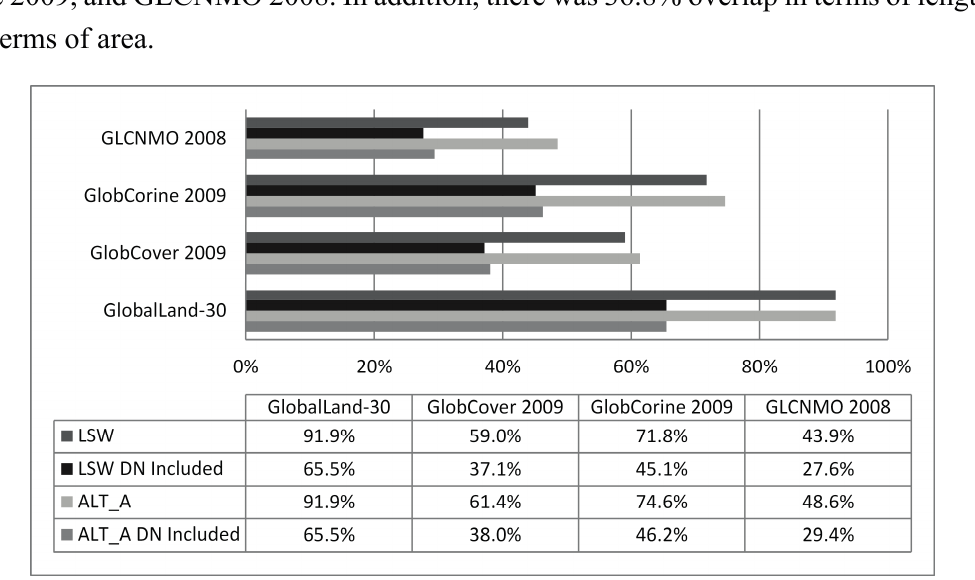
Figure 5. Accuracy assessment results (for GlobalLand30-Water, GlobCover